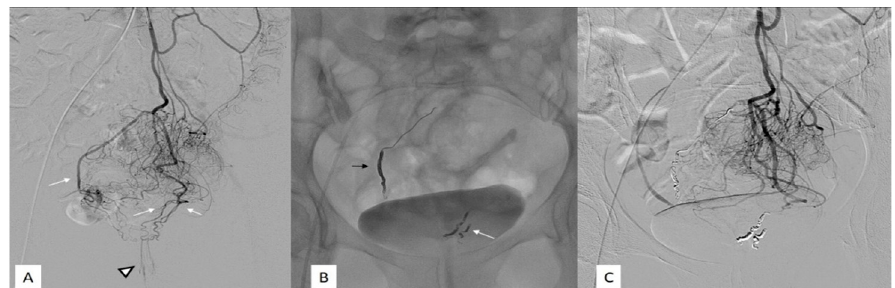
Figure 2. Fifty-two-year-old female with grade IV hemorrhoids disease and a low quality life and inability to do a regular work. ( A ) Subtracted digital arteriography of the inferior mesenteric artery. Visualization of the rectal branches (white arrows) and of the CCR arteries (black arrowhead) with a type 1 vascularization according to the Thomson classification. ( B ) Non-subtracted single-shot fluoroscopy after embolization with metallic coils of the sigmoidal arteries. On the left, a proximal embolization with a packing coil (black arrow). On the right, a more distal embolization with regular coils (white arrow). ( C ) Subtracted digital arteriography of the inferior mesenteric artery after embolization shows complete exclusion of the CCR arteries (no vascularization below the pubic symphysis).